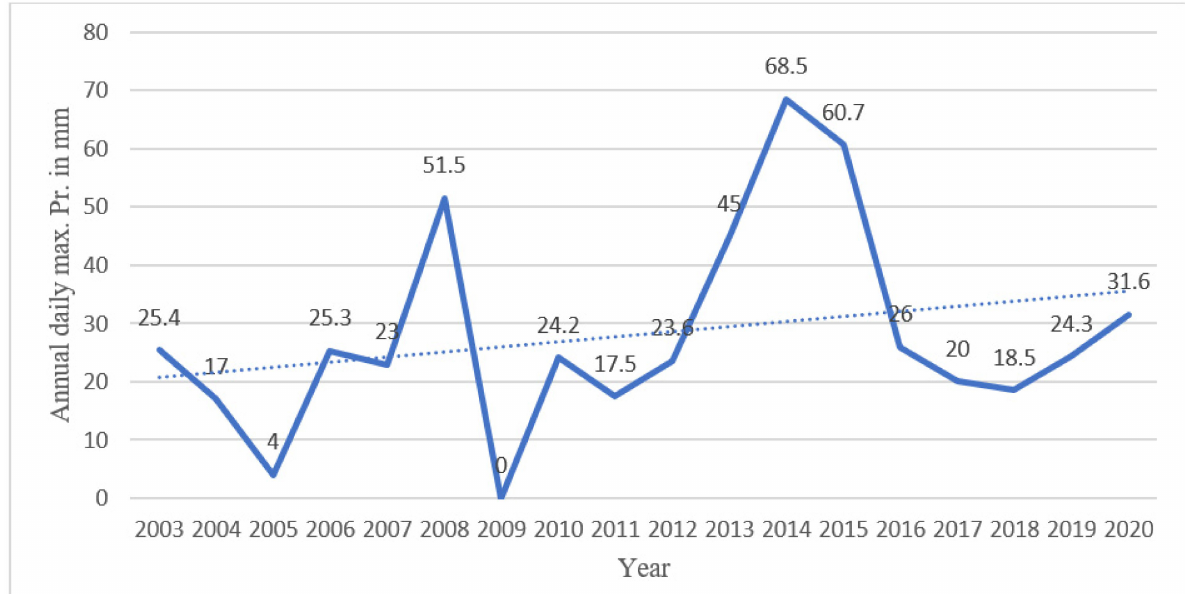
Figure A10. Observed annual daily maximum precipitation of Jomsom,